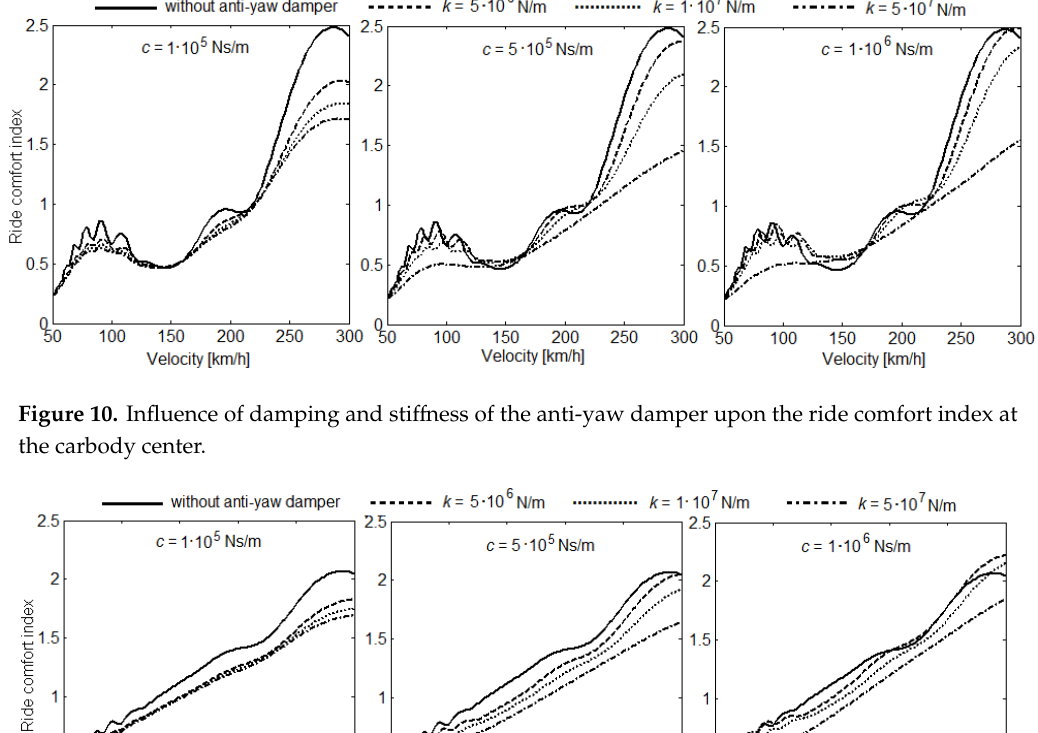
Figure 12. Influence of damping and stiffness of the anti-yaw damper upon the ride comfort index in the rear bogie.